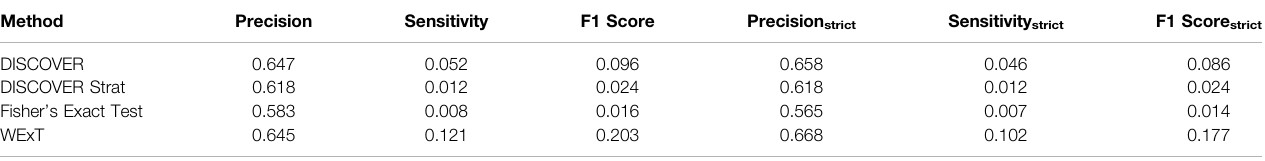
TABLE 3 | Results of network-centric ME evaluation framework with control group X 1 COADREAD t5 (498 samples, 1748 CGC-CGC pairs).